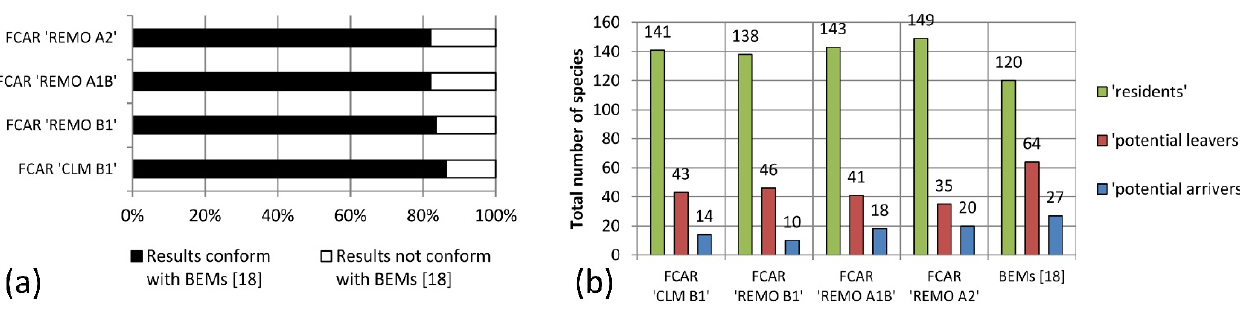
Figure 6. ( a ) Percentage of results of the species pool comparisons of each FCAR that conformed with the bioclimatic envelope models (BEMs) of Huntley et al. [18] for the LHR ( n = 184); ( b ) Absolute numbers of “residents,” “potential leavers,” and “potential arrivers” in the FCARs and according to Huntley et al.